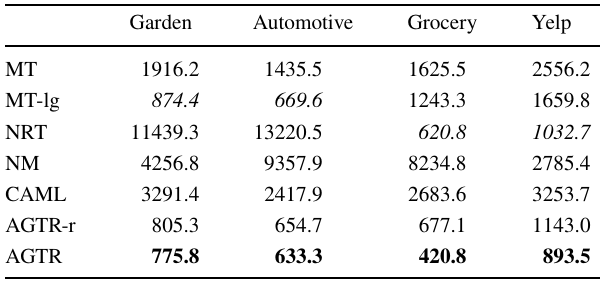
Table 4 Review generation performance in terms of NLL Garden